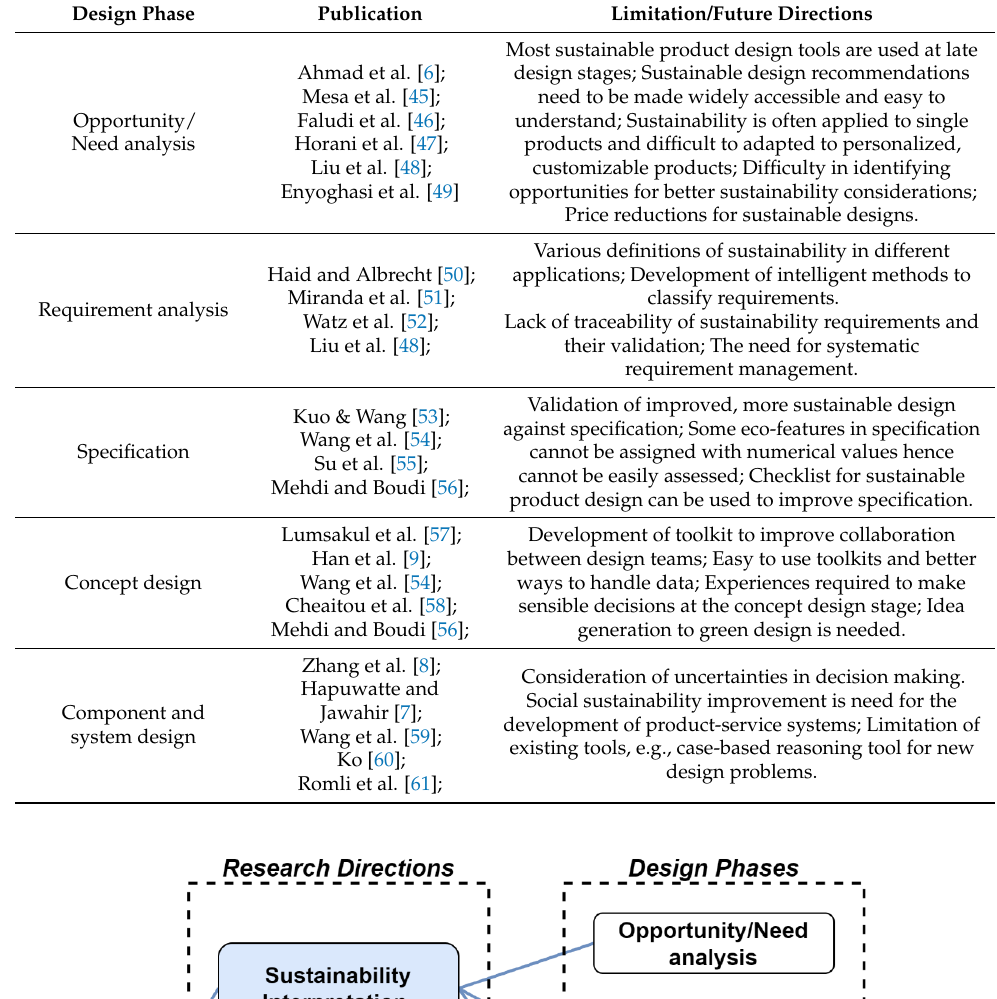
Table 5. Examples of publications that consider sustainability in design phases.